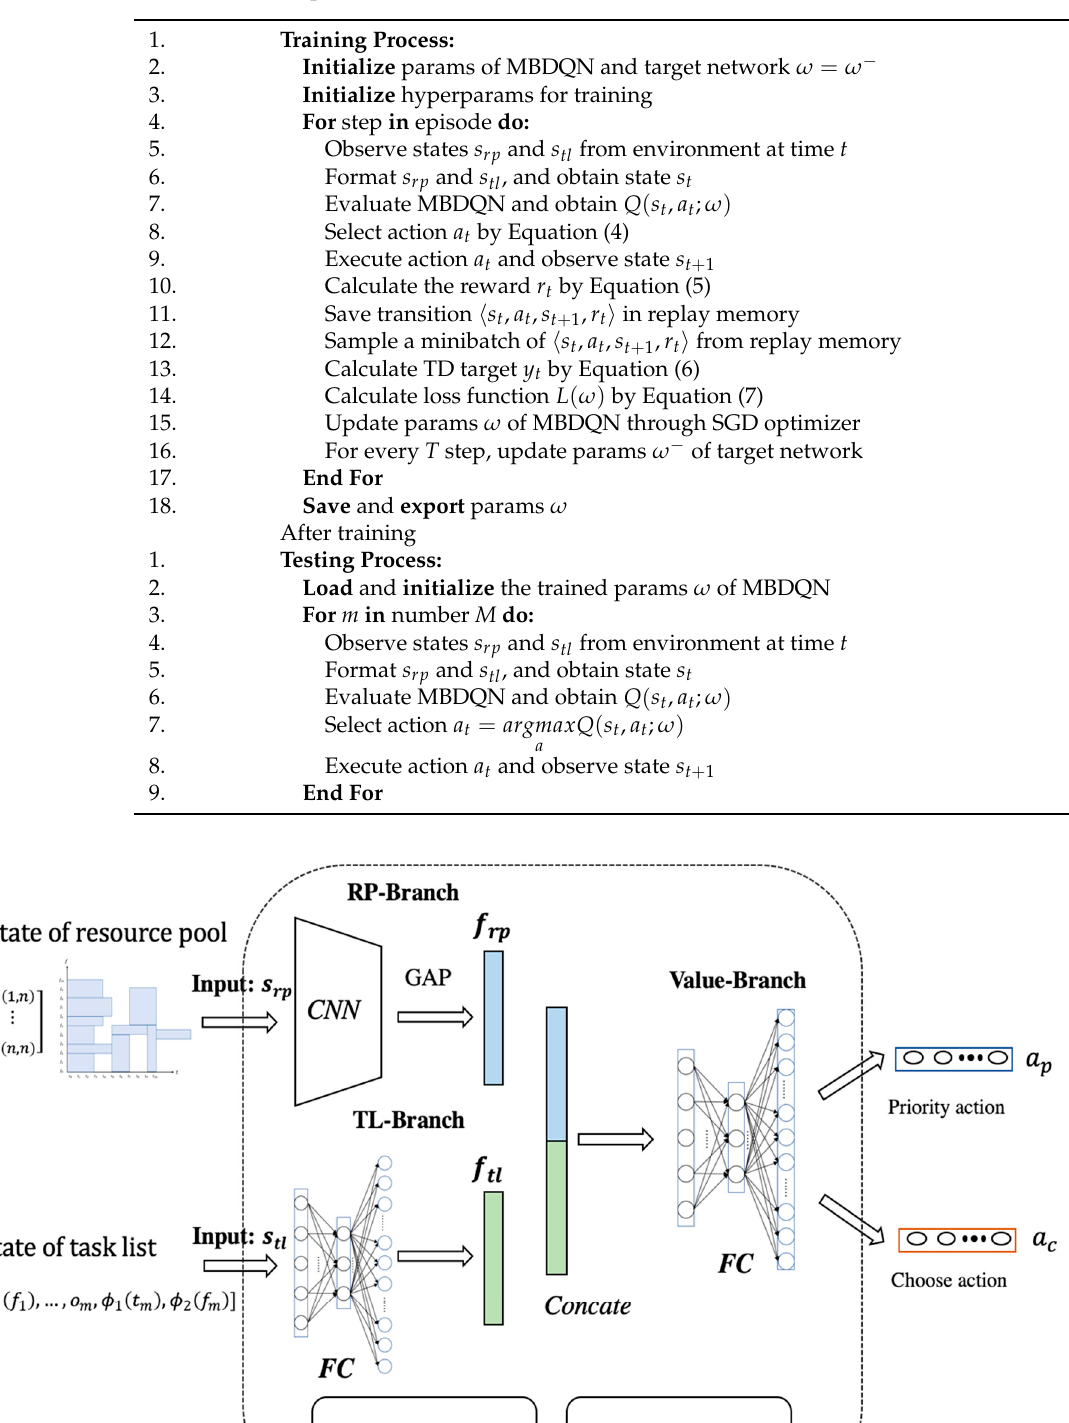
Table 2. Overall operations of the MBDQN model.